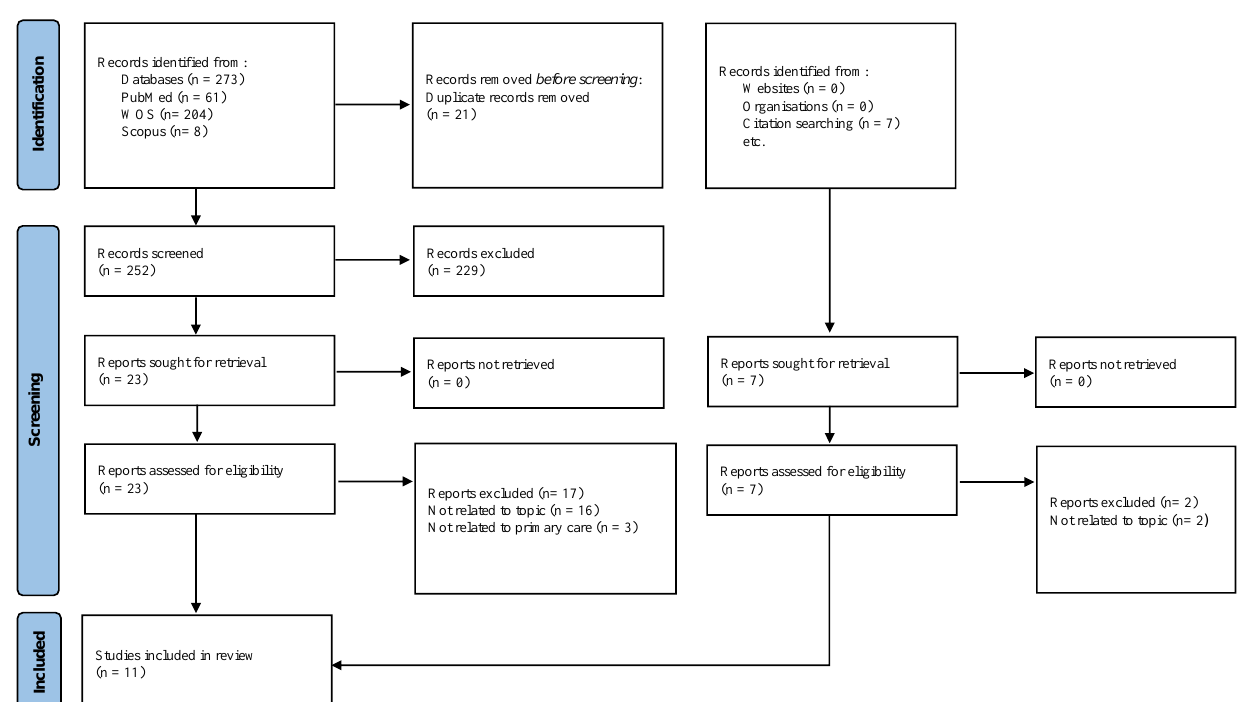
Figure 1. PRISMA. Figure 1.